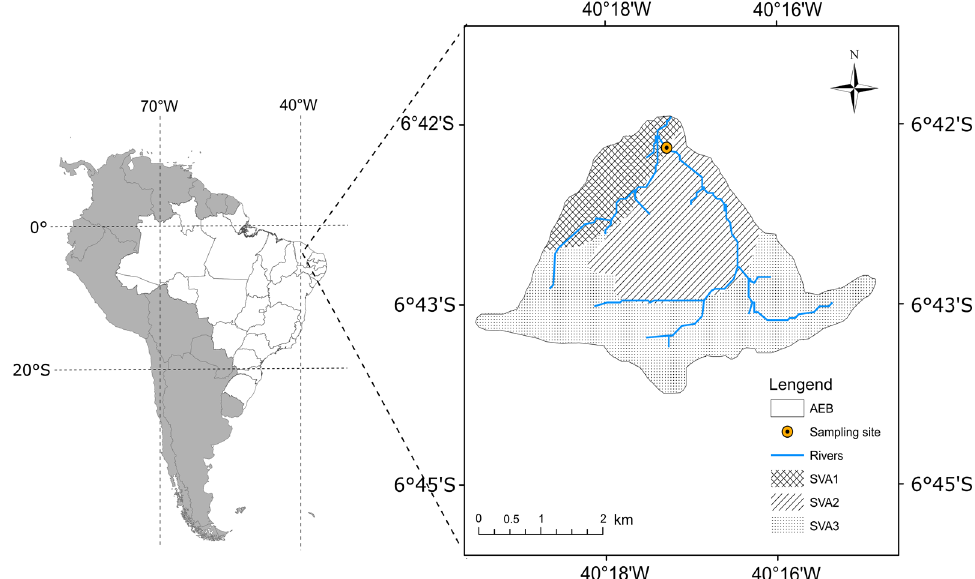
Figure 1. Geographical location of the Aiuaba Experimental Basin (AEB) and its subdivision into Soil and Vegetation Associations (SVA), showing the position of rivers and sampling site for soil hydraulic properties.